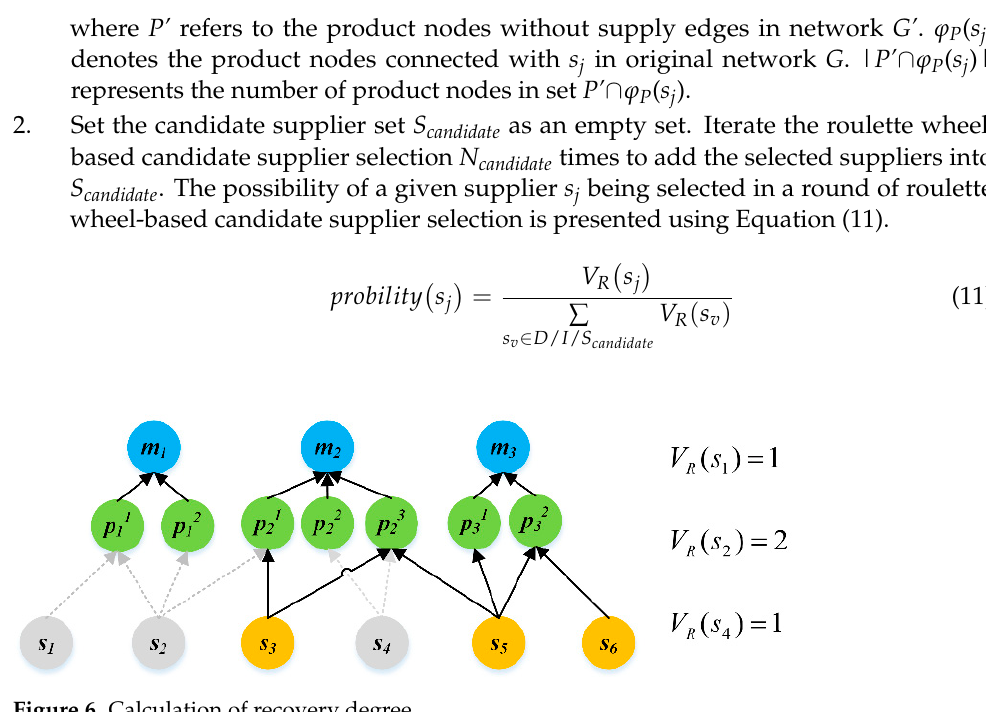
Figure 6. Calculation of recovery degree. Algorithm 3. Recovery Degree-based Local Neighborhood Structure